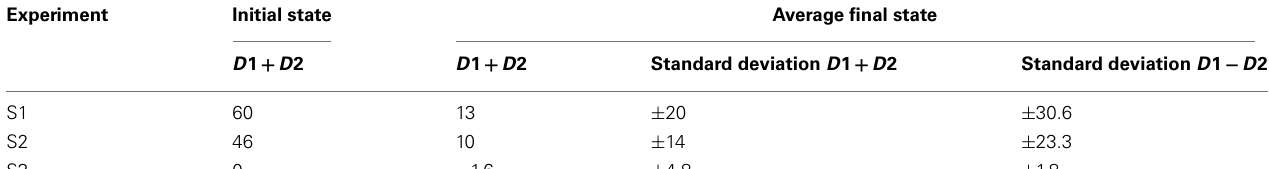
Table 3 |The initial and final values of ( D 1 + D 2), measured in pixels – experiment 3. Experiment